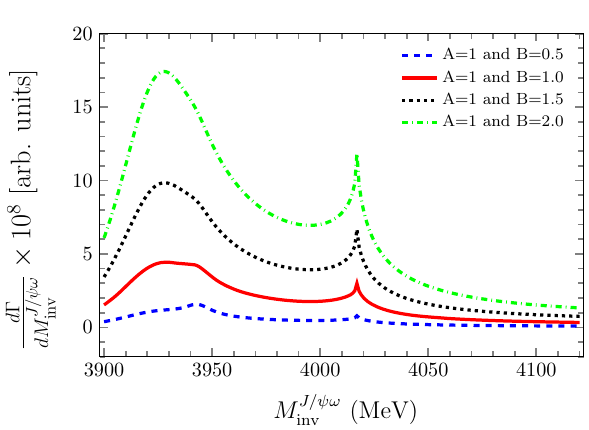
D + → π + f 2 ( 1270 ) . Indeed, the f 0 ( 1370 ) and f 2 ( 1270 ) are obtained from the interaction of ρρ in [10–12]. They are the equivalent in the light sector to the X ( 3940 ) and X ( 3930 ) studied here in the heavy quark sector. The branching ratios are ( 8 ± 4 ) × 10 − 5 and ( 4 . 8 ± 0 . 8 ) × 10 − 4 , respectively, with the resonances decaying to π + π − [16]. Correcting by 3 to account for π 0 π 0 decay of the I = 0 state, and divid- 2 ing by the branching fractions to ππ from the PDG [16], we obtain the rates ( 4 . 6 ± 2 . 3 ) × 10 − 4 and ( 8 . 5 ± 1 . 4 ) × 10 −